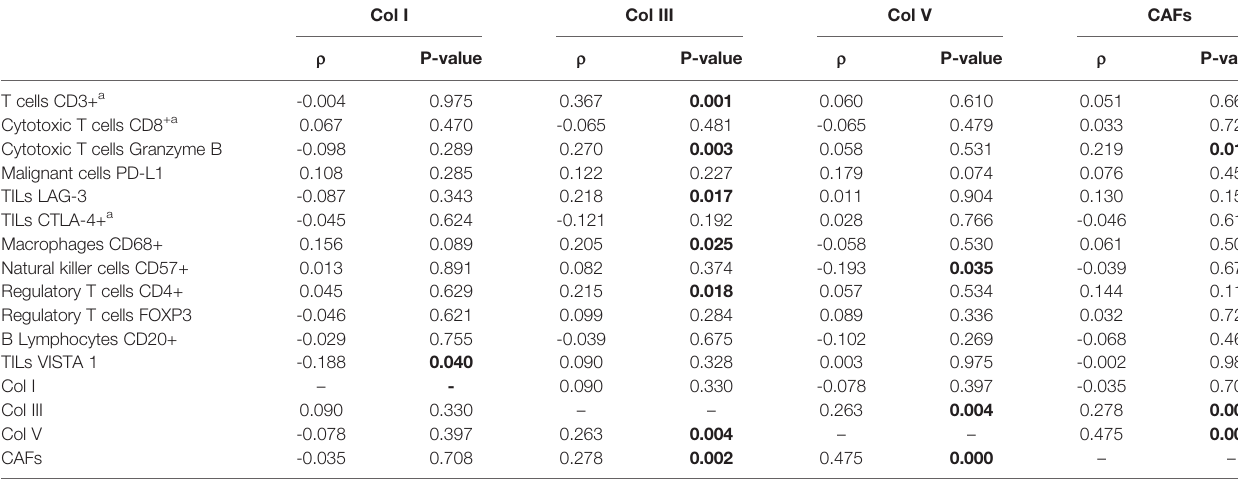
TABLE 2 | Correlation between immune cells, collagen types, and cancer-associated fi broblasts (N = 120; Spearman correlate, P < 0.05). Col I Col III Col V CAFs r P-value r P-value r P-value r P-value T cells CD3+